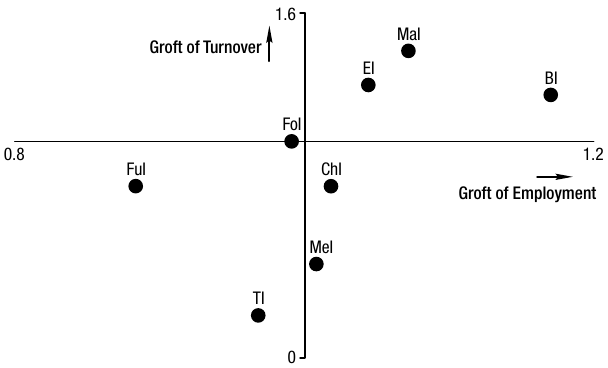
Fig. 4. Industrial clusters potential measured by localization